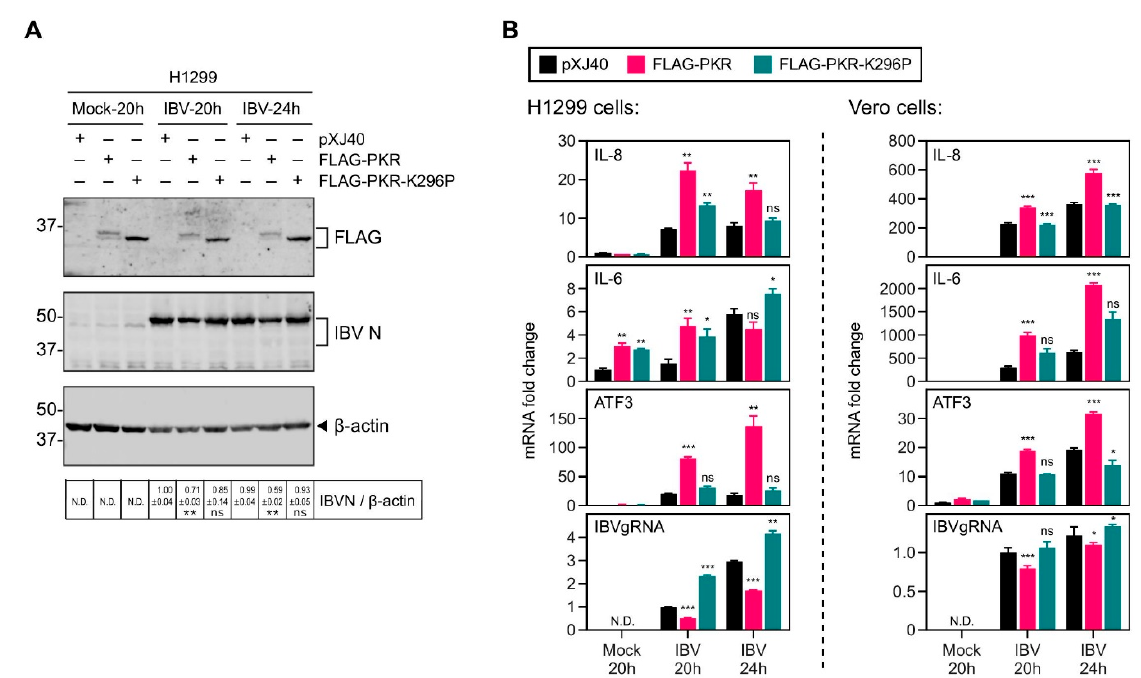
Figure 2. Overexpression of PKR increased the induction of IL-8 mRNA in cells infected with IBV. ( A ) H1299 cells were transfected with pXJ40 , pXJ40-FLAG-PKR , or pXJ40-FLAG-PKR-K296P , before being infected with IBV at MOI~2 or mock infected (M). Cell were harvested at the indicated time points and subjected to Western blot analysis using the indicated antibodies. Beta-actin was included as the loading control. Sizes of protein ladders in kDa are indicated on the left. Significance levels are presented by the p value (**, p < 0.01; ns, non-significant). ( B ) Total RNA samples were extracted from cells in ( A ) and subjected to RT-qPCR. The levels of IL-8, IL-6, ATF3, and IBV genomic RNA were determined by the ΔΔ Ct method using the GAPDH mRNA of the pXJ40-transfected, 20 h post mock-infected sample for normalization. Vero cells were transfected, infected, and analyzed similarly. The experiment was repeated three times with similar results, and the result of one representative experiment is shown. Significance levels were presented by the p -value (ns, non-significant; *, p < 0.05; **, p < 0.01; ***, p < 0.001; N.D., non-determined).